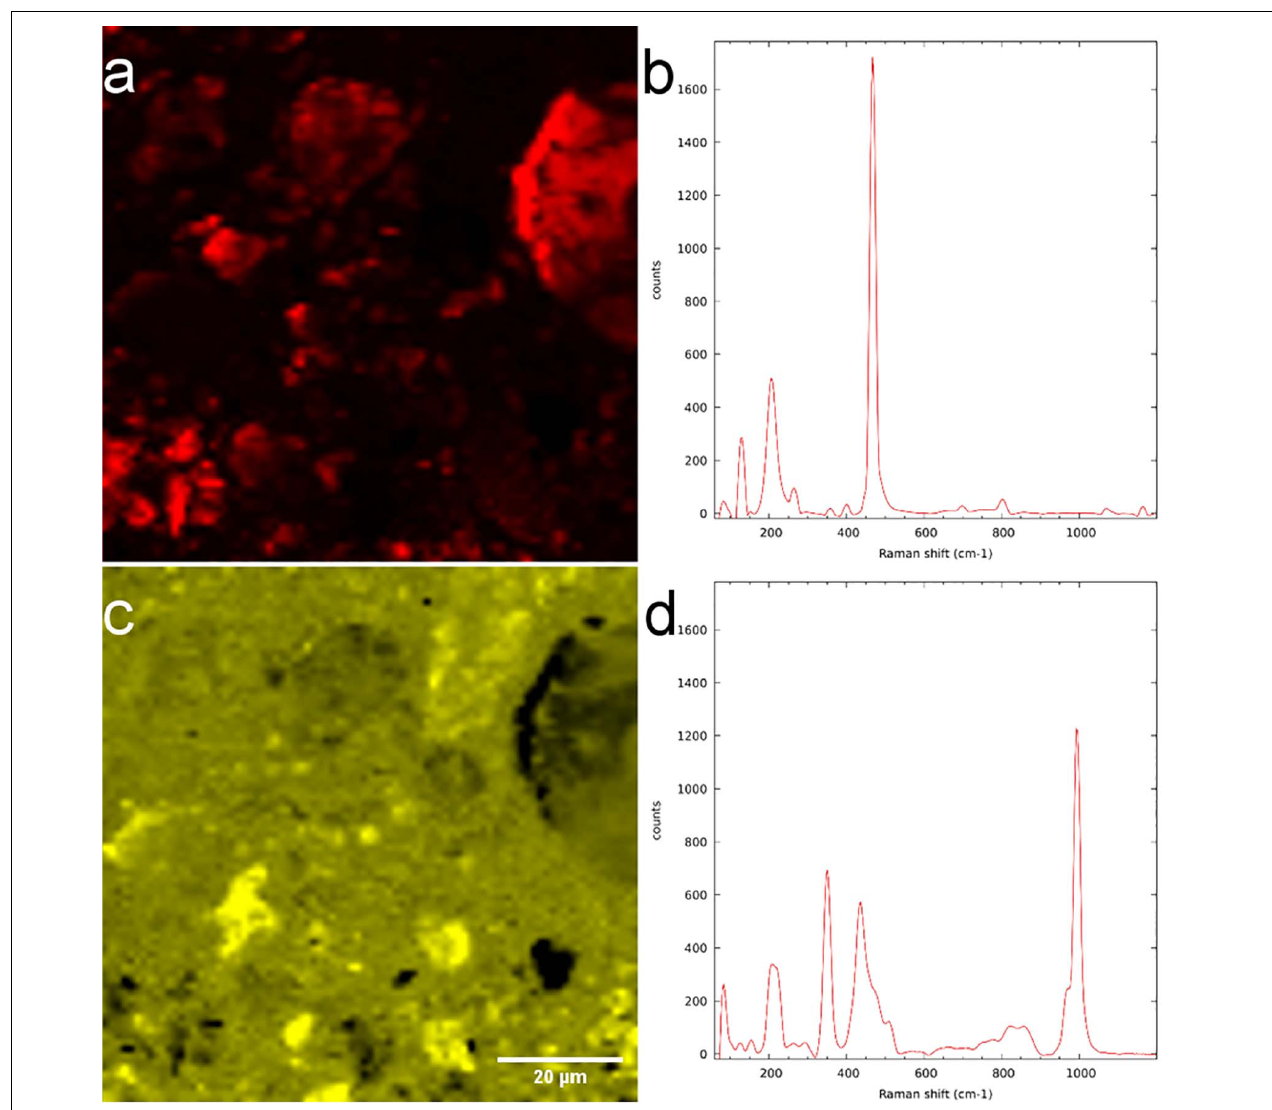
FIGURE 7 | µ -Raman measurement of LR white resin-embedded soil. (a) Quartz-distribution map and (b) spectrum. (c) Mixture of zircon and aluminum-containing minerals and their (d) spectrum.